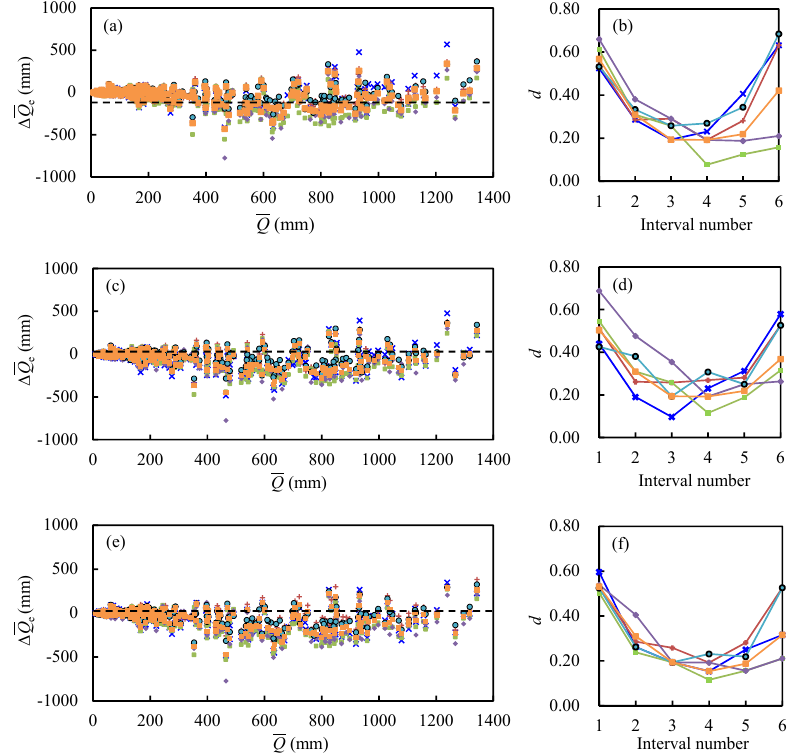
Figure 11. Projections of future trends (cid:49)Q e under RCP2.6 (top panels), RCP4.5 (middle panels), and RCP8.5 (bottom panels) scenarios for the period 2001–2050. (a, c, e) Relationship between projected (cid:49)Q e of the five models and their means and mean annual runoff Q . (b, d, f) Values of d in each interval according to Q based on (cid:49)Q e of the five models and their means. Interval numbers 1 to 6 correspond to six intervals of 0–200, 200–400, 400–600, 600–800, 800–1000, and 1000–1400, respectively.